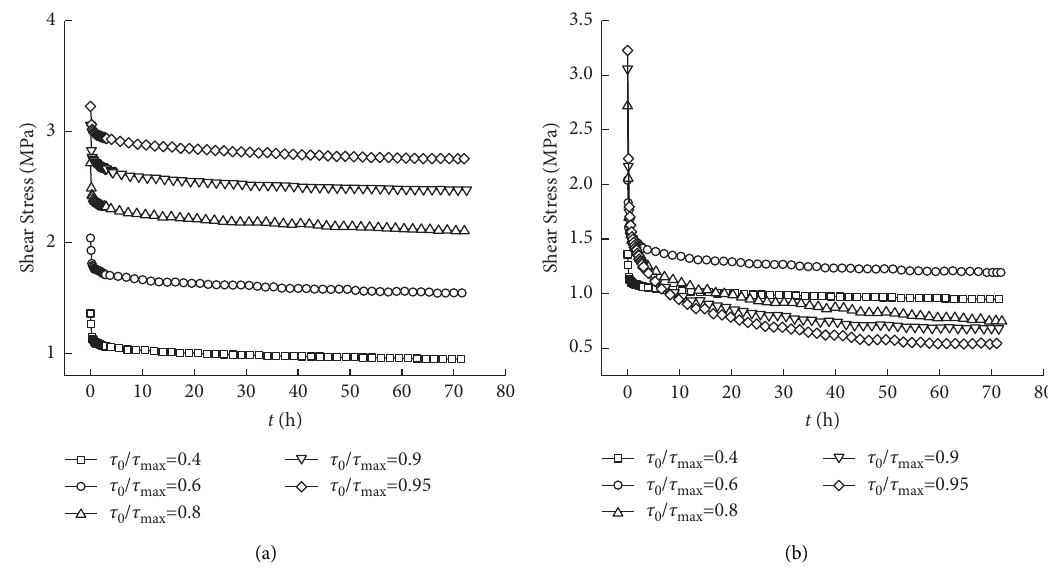
Figure 9: Relaxation curves of 10 ° discontinuities under different stress levels: (a) before superposition, τ � perposition, τ 0